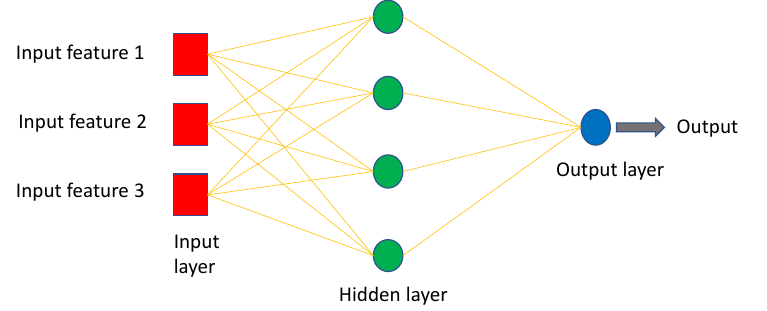
Figure 5. Simple MLP